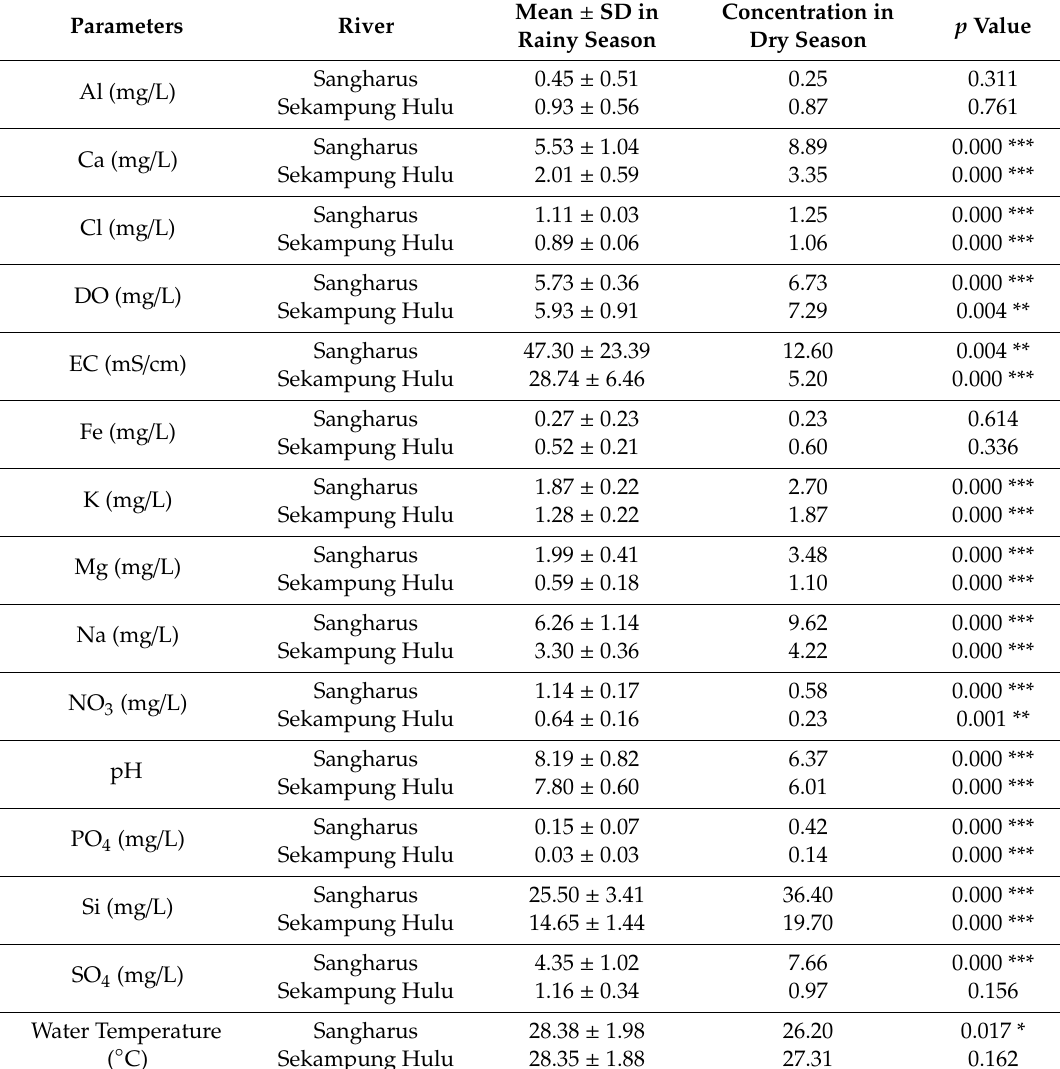
Table 2. Seasonal patterns of water quality concentration between the rainy and dry seasons.